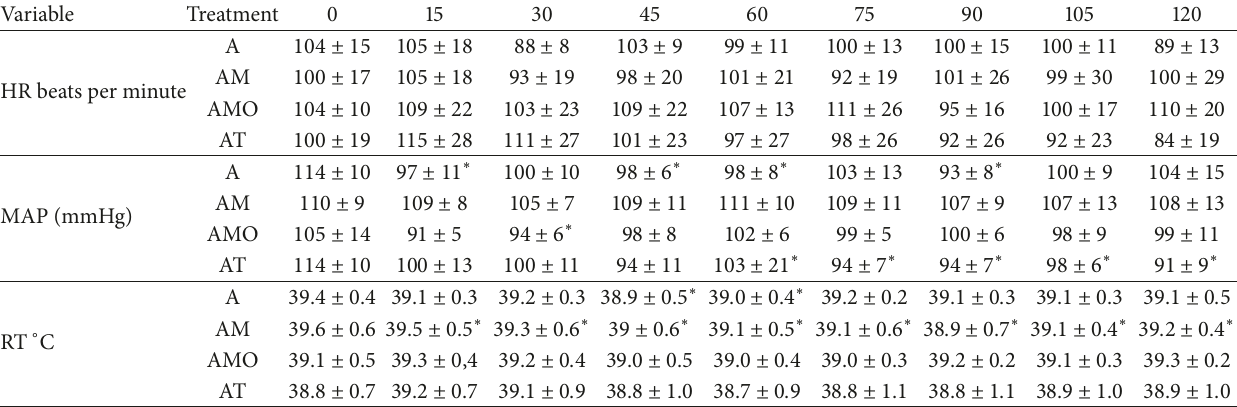
Table 1: Mean ± standard deviation of heart rate (HR), mean arterial pressure (MAP), and rectal temperature (RT) in six ewes sedated with acepromazine alone (A), acepromazine-methadone (AM), acepromazine-morphine (AMO), or acepromazine-tramadol (AT).